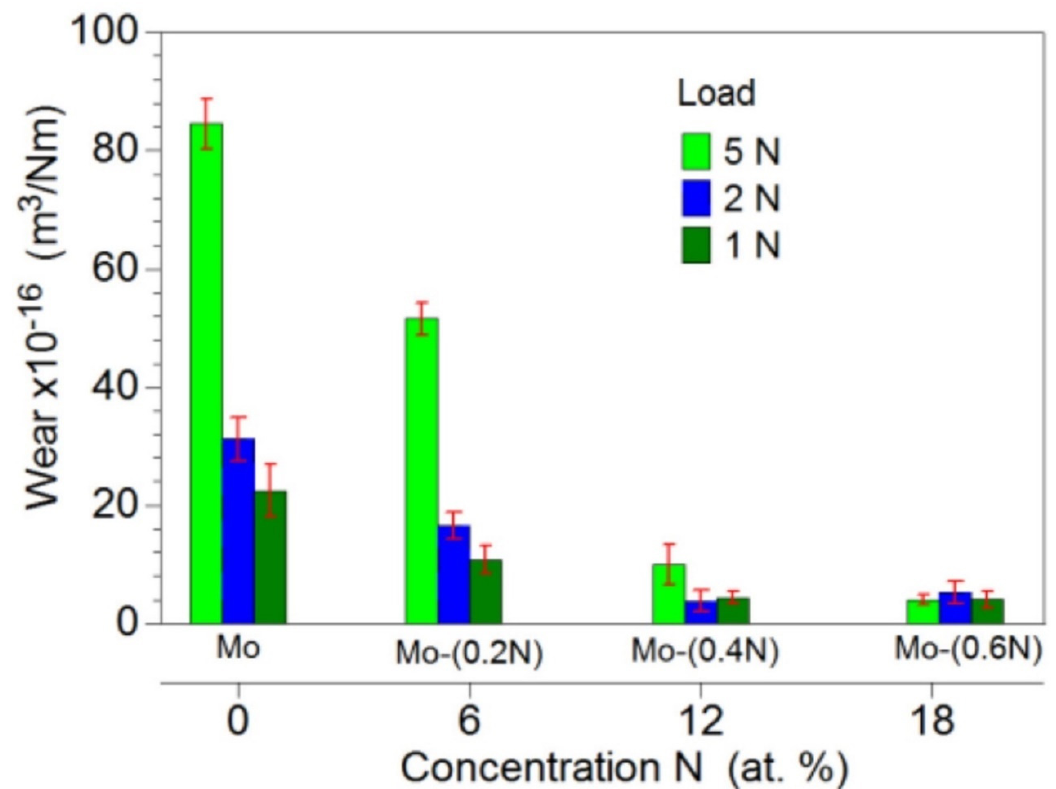
Figure 10. Wear of Mo-Mo 2 N coatings with varying concentrations of N [193].